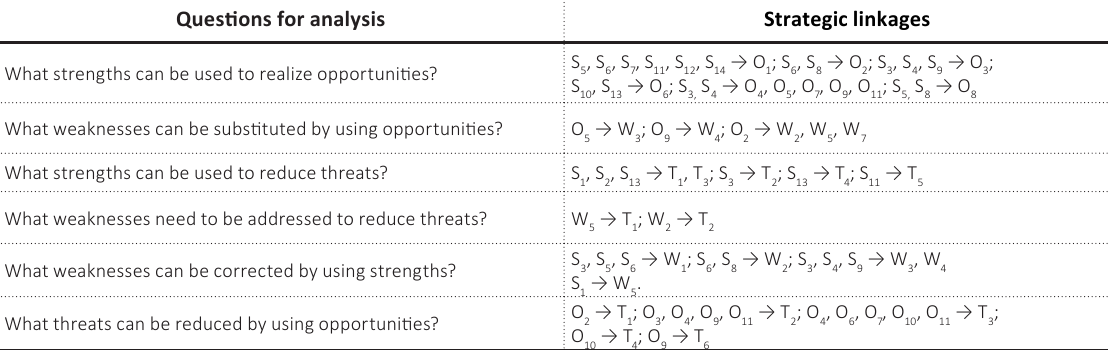
Table 2. Possibilities for using the strategic linkages from the SWOT-matrix for developing the